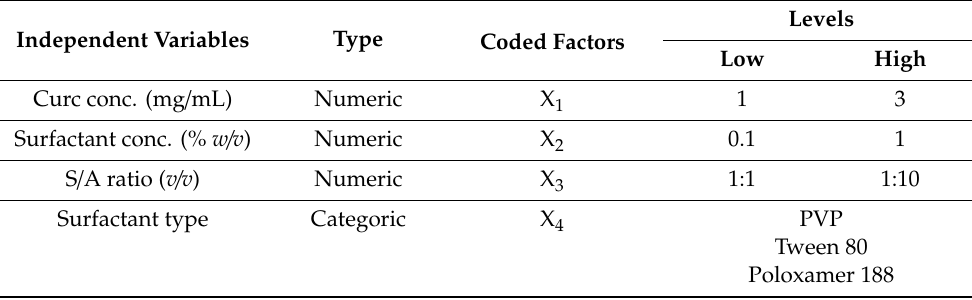
Table 1. Factors and the corresponding levels investigated by the Box Behnken